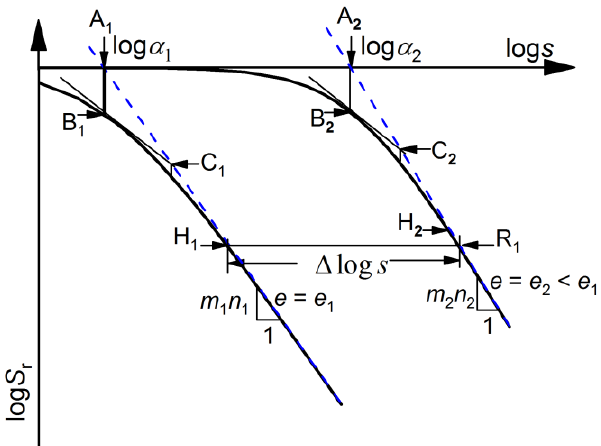
Figure 5. Main drying curves on the plane e.